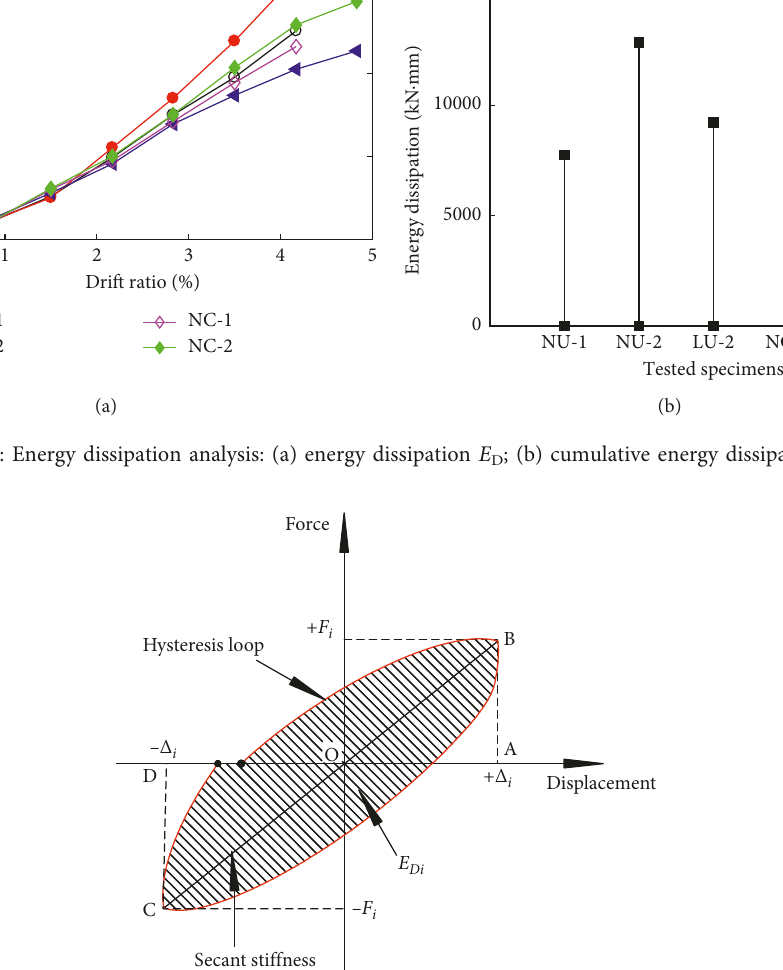
Figure 10: Schematic diagram of energy dissipation and secant stiffness.